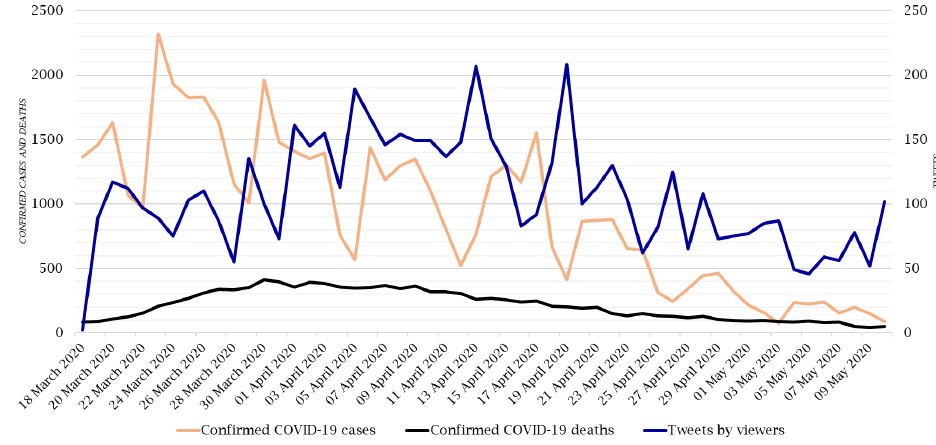
Figure 3. Confirmed COVID-19 cases and deaths and tweets by viewers.